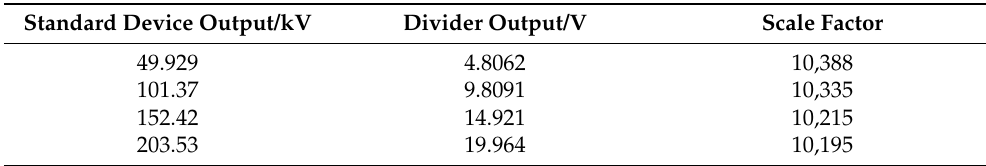
Table 2. DC test results at room